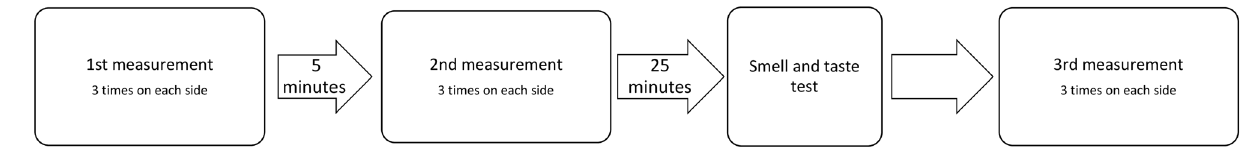
Figure 2. Workflow of the